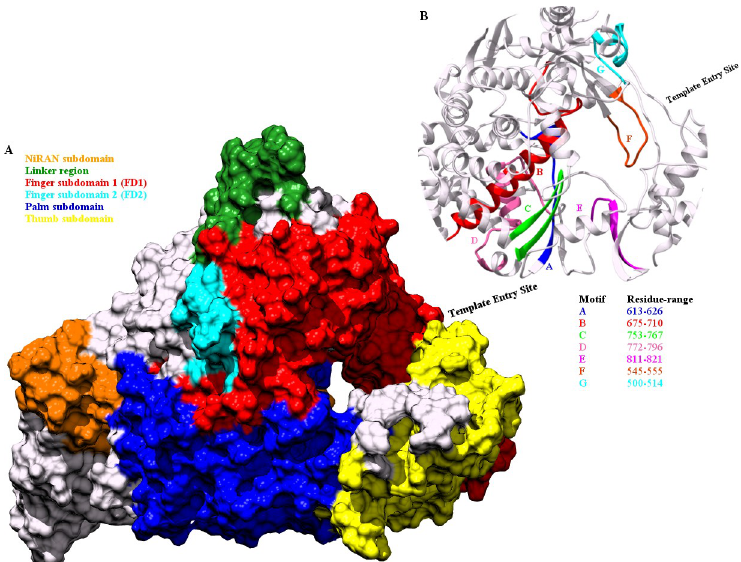
Fig 1. Structure of RdRP of SARS-CoV-2. The different (A) subdomains and (B) the seven conserved motifs in RdRP of SARS-CoV-2 represented through color codes.